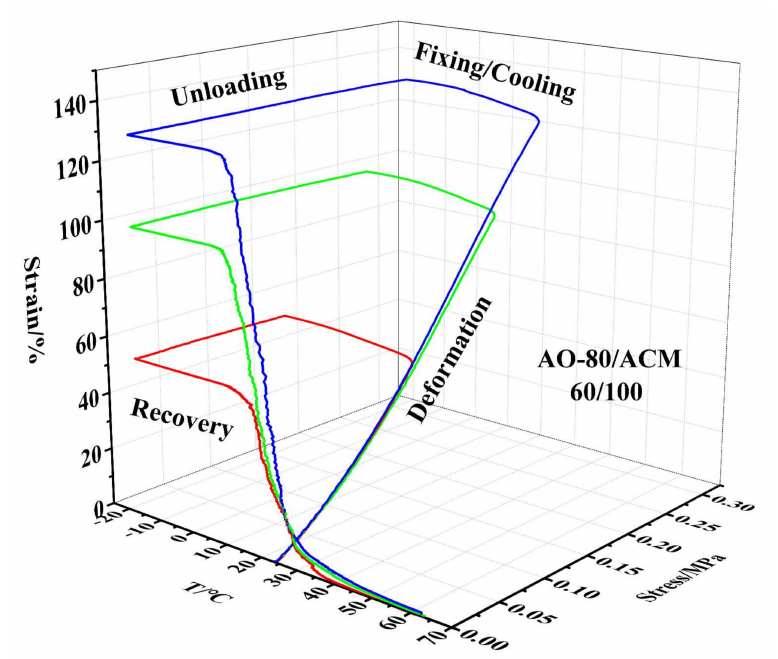
Figure 8. 3D ε -T- σ curves of different strains (deformation) for AO-80/ACM (60/100) rubber composite.